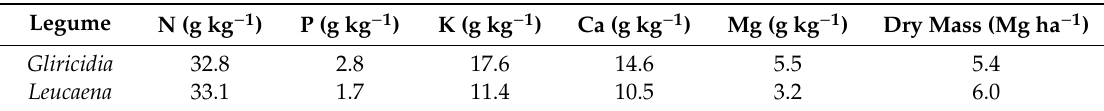
Table 2. Macronutrient content and dry mass of plant residues deposited between lines of sorghum cultivation (double crop) in March 2017.